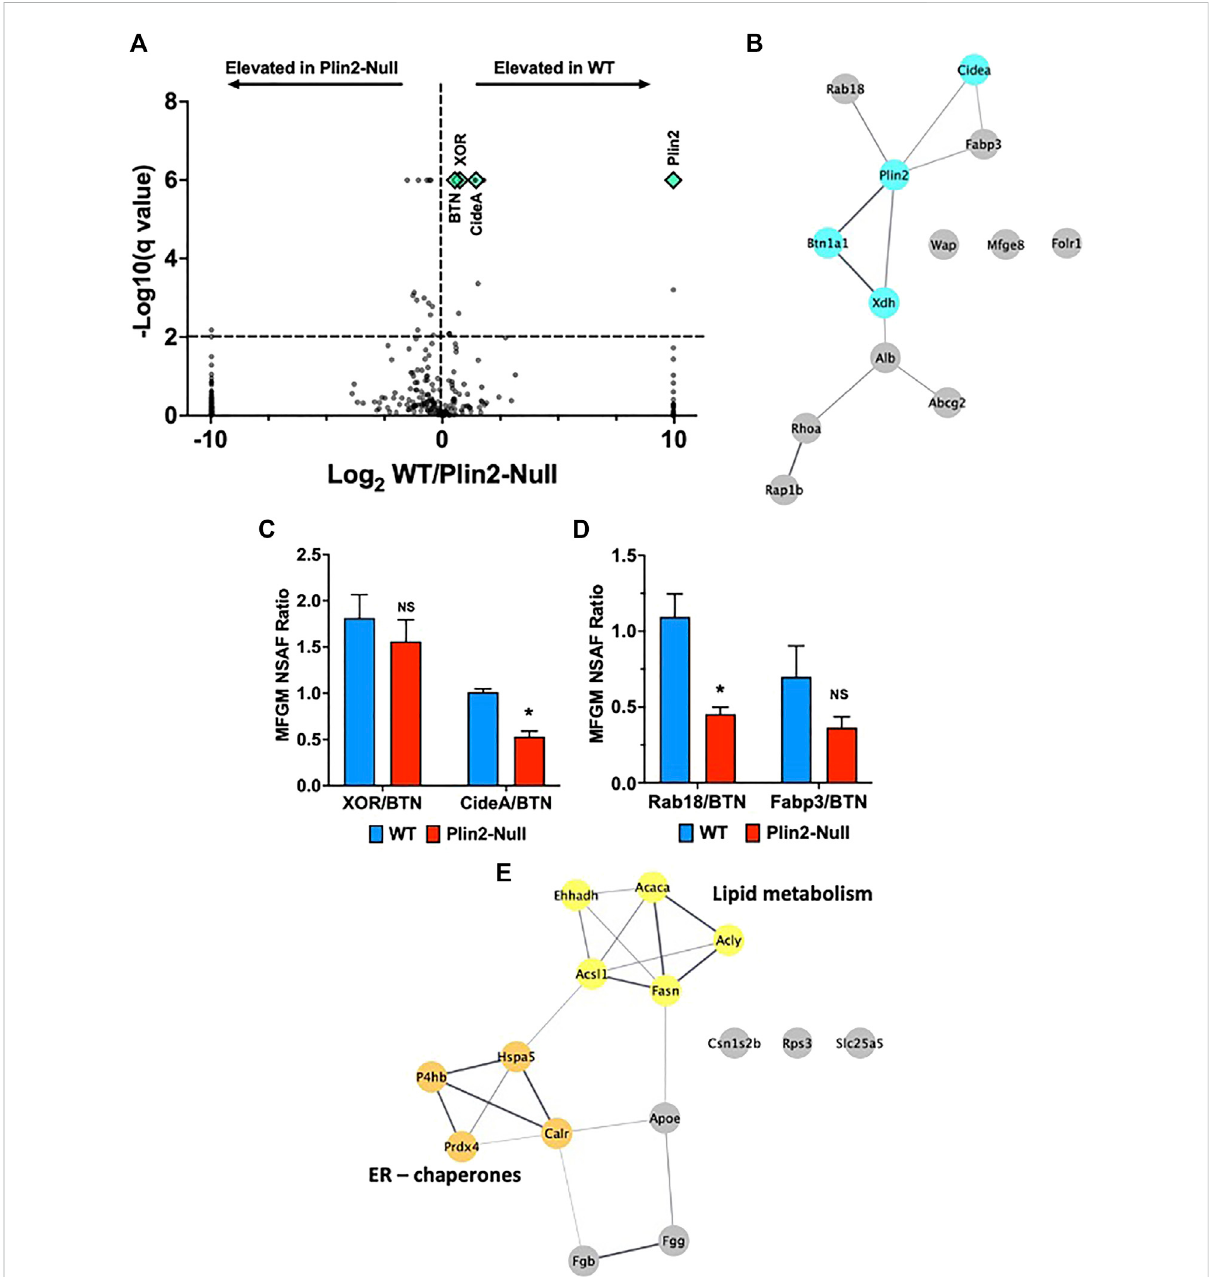
FIGURE 3 Milk fat globule membrane (MFGM) protein composition. (A) Volcano plots showing log 2 fold change in normalized spectral abundance factor (NSAF)ratiosforproteinsinWTandPlin2-NullMFGMversus − log 10 oftheirq-values,multipleunpairedttestswithFDR=1%.Forpurposesofdisplay, proteins present in WT MFGM but absent in Plin2-Null MFGM were assigned NSAF ratios of 1,000 (Log 2 = 10). Proteins present in Plin2-Null MFGM but absent in WT MFGM were assigned NSAF ratios of 0.001 (Log 2 = − 10). Proteins with q-values ≤ 0.000001 are assigned values of 0.000001 (log 10 =6).WTenrichedMFGMproteinsarerightandPlin2-NullenrichedMFGMproteinsareleftoftheverticaldottedline.ProteinsfoundatLD-APM contact sites, BTN, XOR, Cidea and Plin2, are indicated by green diamond symbols. The horizontal line indicates q = 0.01. (B) STRING networks of proteins elevated (q > 0.01) in WT MFGM were identi fi ed using Cytoscape 3.9.1. Proteins forming a network with Plin2 include those implicated in formationofLD-APMcontacts(XOR,BTNandCidea)andRab18andFABP3. (C) Average±SEMXOR:BTNandCidea:BTNNSAFratiosinWTandPlin2- Null MFGM. Asterisk indicates p < 0.05, Students t-test. (D) Average ±SEM Rab18:BTN and Fabp3:BTN NSAF ratios in WT and Plin2-Null MFGM. Asteriskindicates p < 0.05,Studentst-test. (E) STRINGnetworksofproteinselevated(q < 0.01)inPlin2-NullMFGMareenrichedinER/chaperoneand lipid metabolism